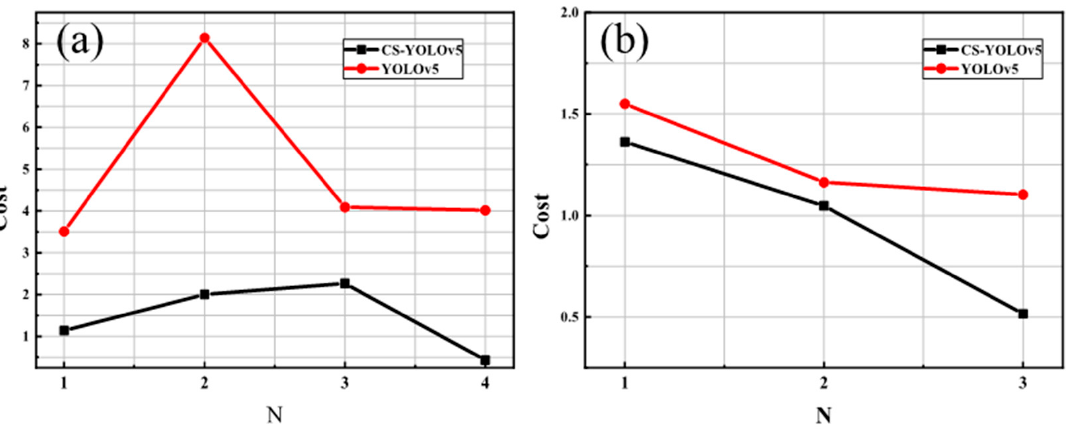
Figure 6. ( a ) Cost (×10 − 3 ) with varying positive classes on NEU ( b ) Cost (×10 − 3 ) with varying positive classes on Paint.